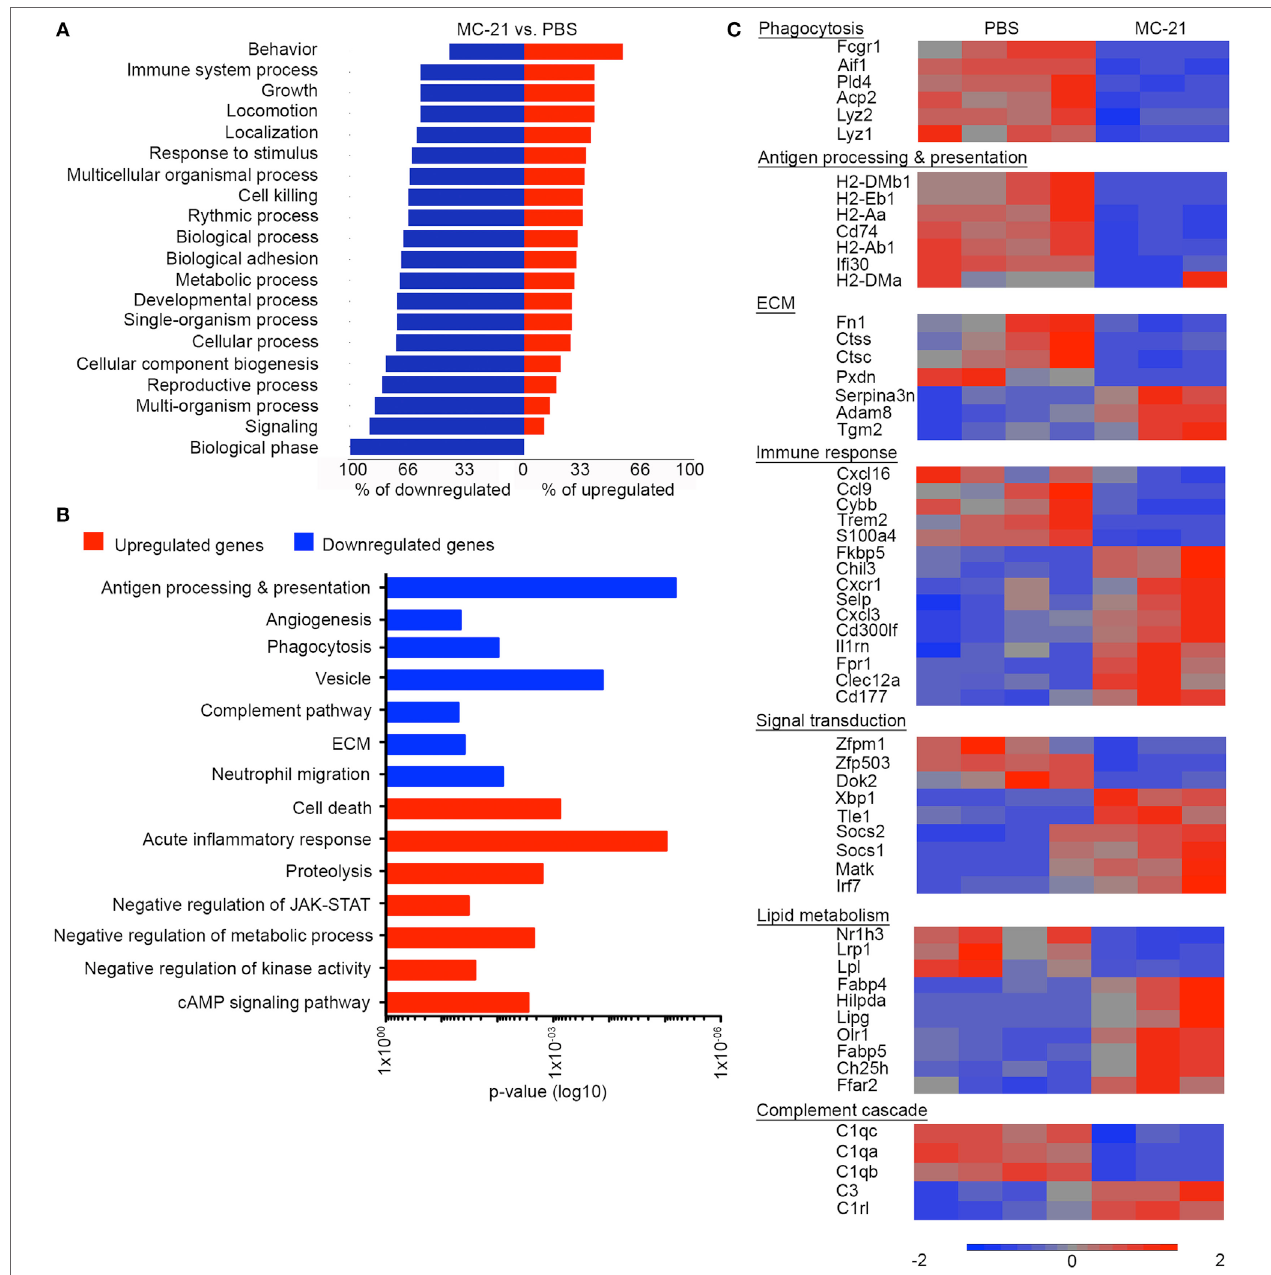
FigUre 5 | altered neutrophil-mediated innate immune functions and cell survival in the absence of ly6c hi monocytes . (a) Forest plot analysis of 449 differentially expressed genes ( p < 0.05; t -test, with at least twofold change) presenting for each biological process the percentage of downregulated genes (in blue) and upregulated genes (in red). (B) Graphic representation of the significance ( p -value) for the enrichment of selected GO categories out of DAVID analyses performed for the downregulated (in blue) and upregulated genes (in red) comparing between “MC-21” versus “phosphate-buffered saline (PBS)” neutrophils. Analysis was performed on the differentially expressed genes ( p < 0.05; t -test, ≥ 2-fold change). (c) RNA-seq heat map analysis displaying the differential expression (z-scored) of genes between “MC-21” and “PBS” neutrophils, which are associated with phagocytosis, antigen processing and presentation, extracellular matrix (ECM) remodeling, immune response, signal transduction, lipid metabolism, and complement cascade. Color legend is presented at the bottom of the figure. Analysis was performed on the differentially expressed genes ( p < 0.05; t -test, ≥ 2-fold